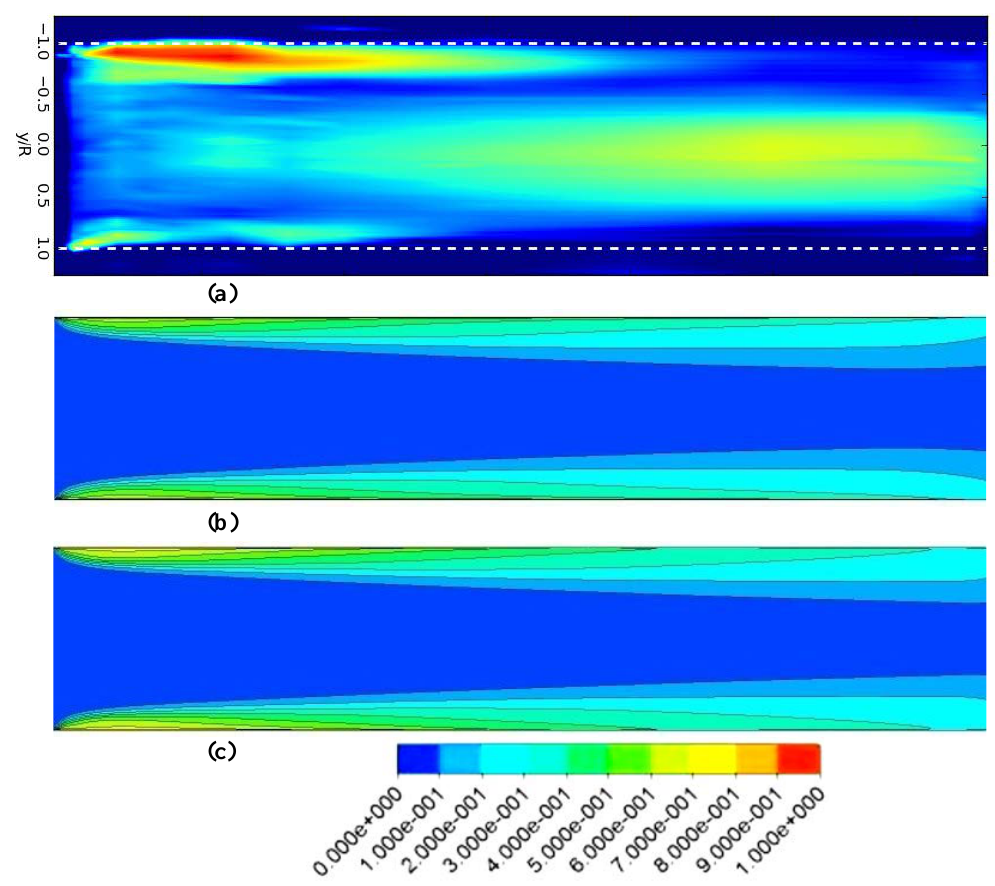
Figure 9. Qualitative comparison between the experimental and CFD predicted results; ( a ) X-ray radiography measurement [15] (reproduced with permission), ( b ) Schnerr and Sauer (SS) model, and ( c ) Zwart-Gerber-Belamri (ZGB) model.